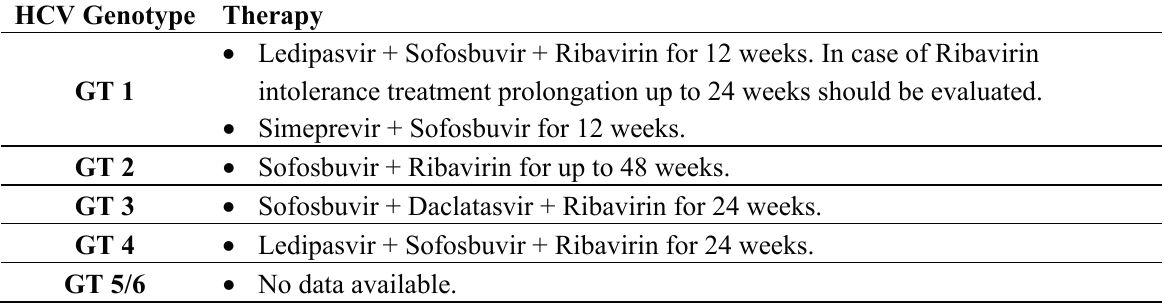
Table 6. Treatment recommendations for patients with decompensated liver cirrhosis. HCV